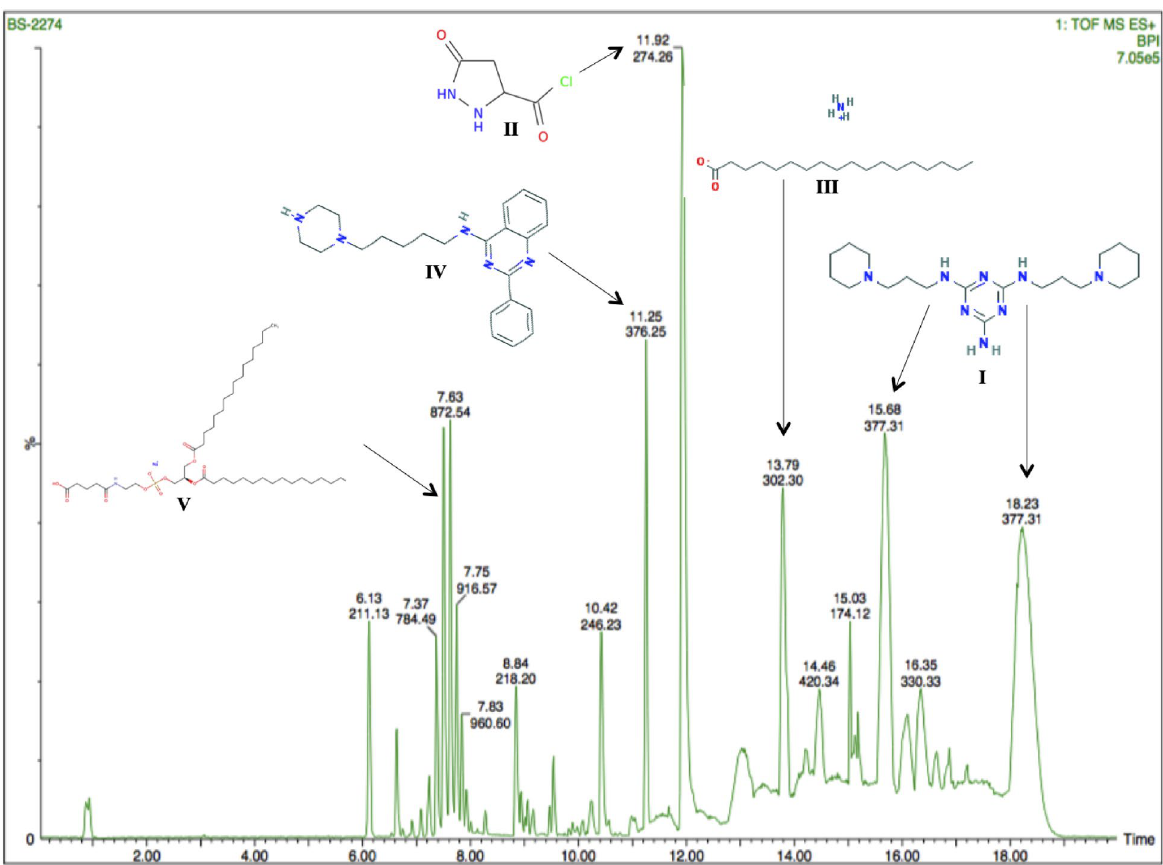
Figure 4. UPLC-MS chromatogram of bioactive fraction of ethyl acetate extract of Bacillus subtilis 2274 with retention time (min) on x-axis and area (%) on y-axis with chemical structure of major five compounds. For name of the compounds refer Table